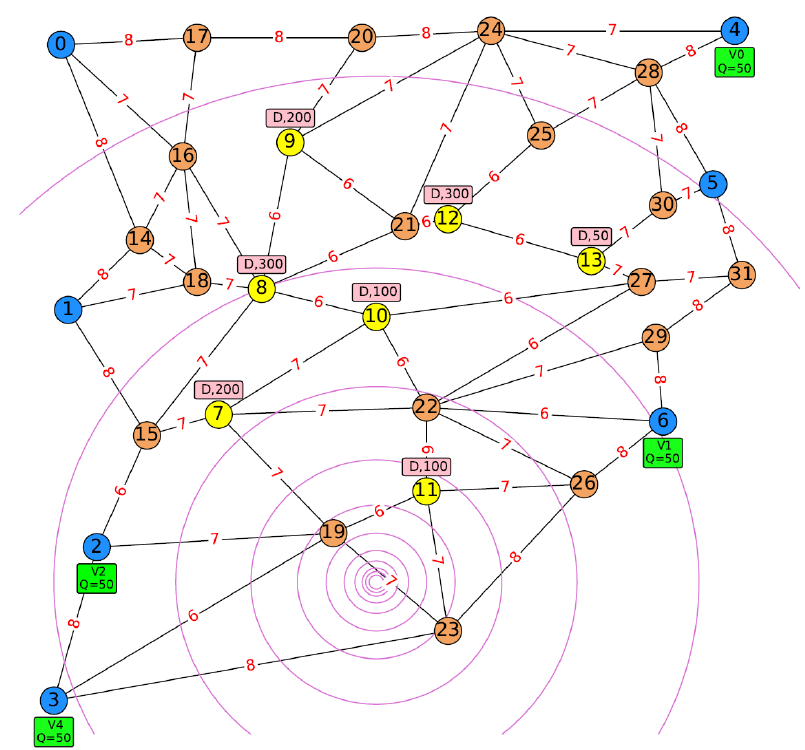
Figure A5. Road network for instance